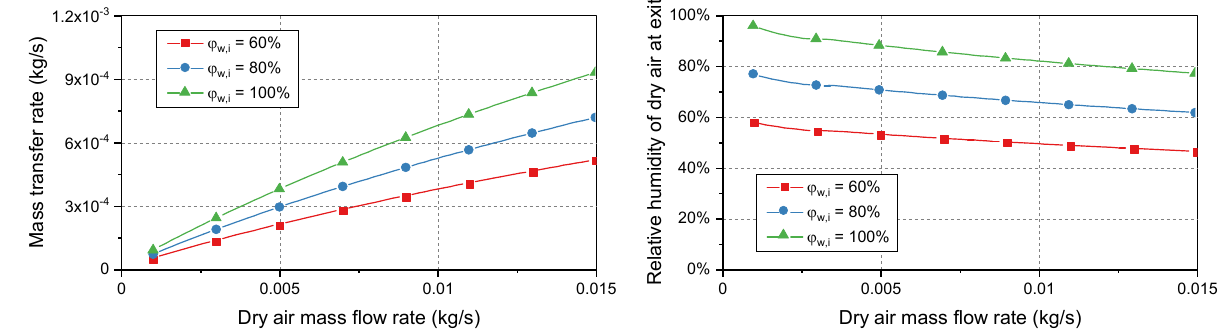
Figure 3. Effects of operating relative humidity on the mass transfer rate and relative humidity of dry air.